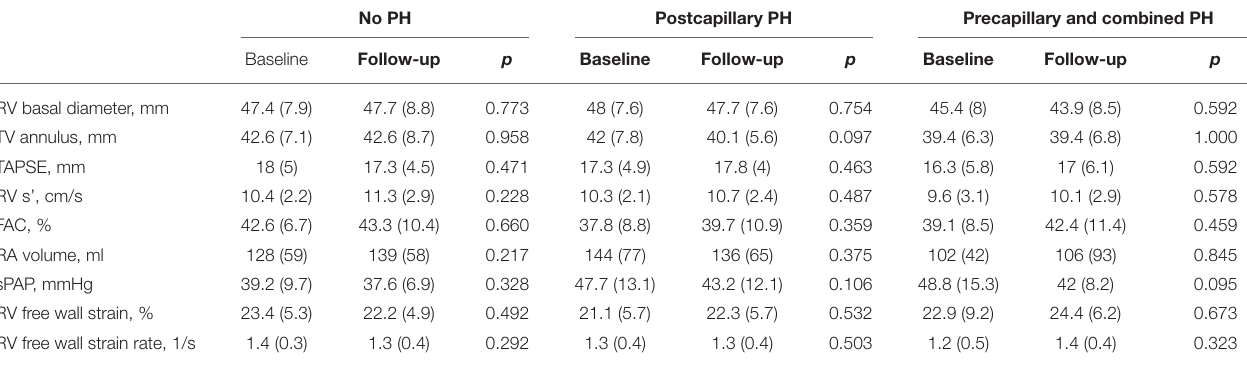
TABLE 5 | Comparison of right ventricular parameters at baseline and follow-up for different PH groups. No PH Postcapillary PH Precapillary and combined PH Baseline Follow-up p Baseline Follow-up p Baseline Follow-up p